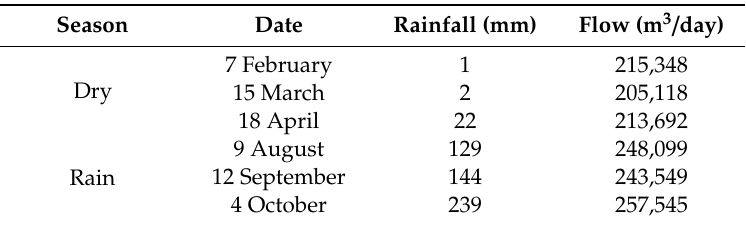
Table 3. Rainfall of Cartagena and flow of the submarine Outfall.